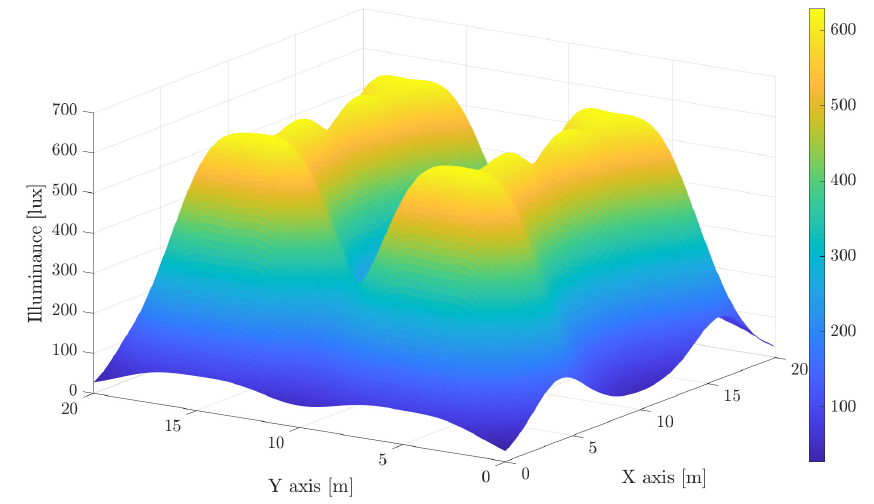
Figure 1. Illuminance in an indoor scenario. Beam angle of 20 ◦